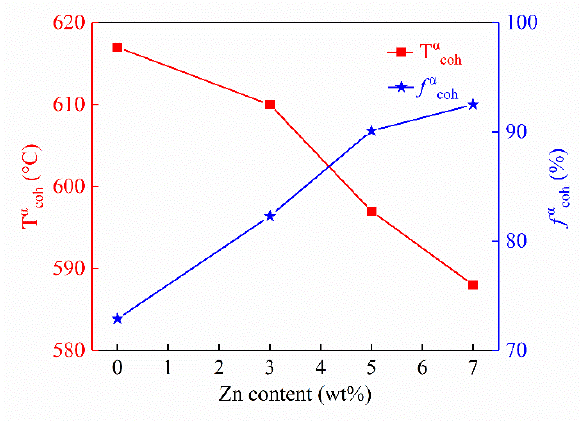
Figure 6. The change of T α coh and f α coh with Zn content.